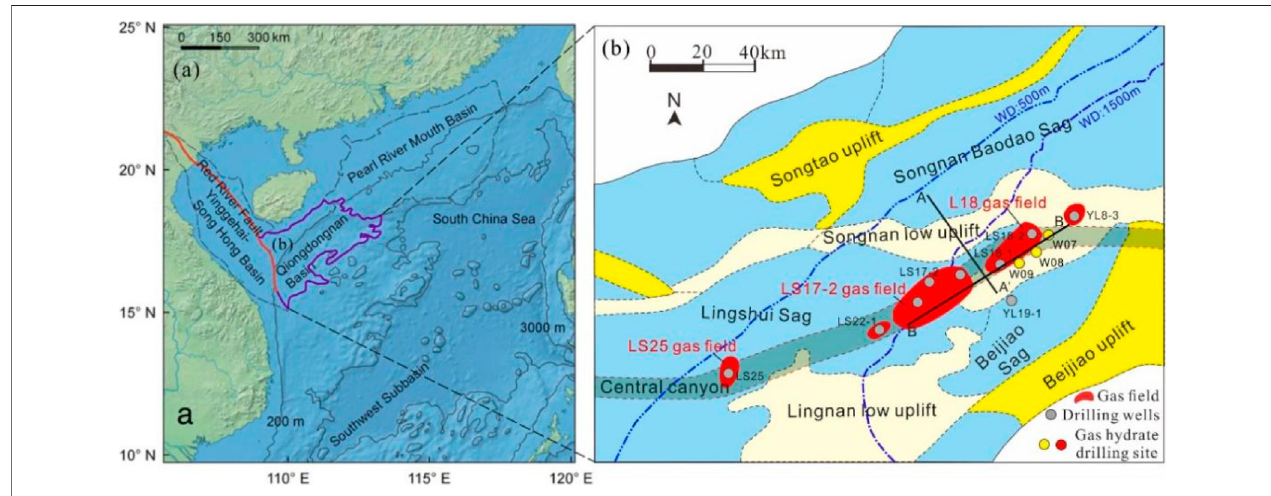
FIGURE 1 | (A) Location of the Qiongdongnan Basin (QDNB) with purple color in the northwestern South China Sea. (B) Structural sketch of the western QDNB (modi fi ed after He et al., 2021) with gas fi elds and drilling wells being labeled. WD, water